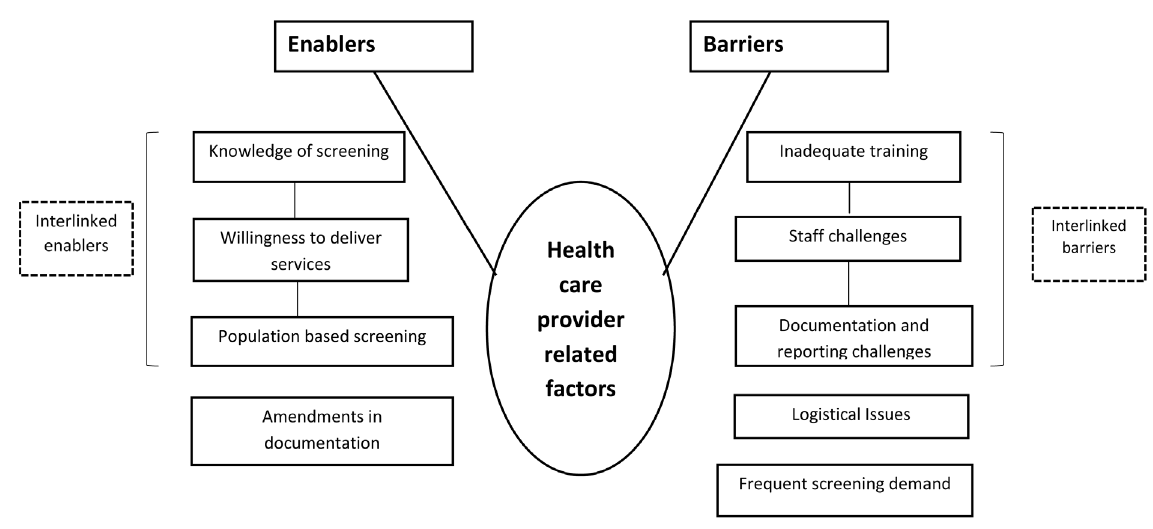
Figure 3. Non-hierarchical thematic map showing enablers and barriers in the implementation of opportunistic screening for diabetes melitus and/or hypertension among persons aged ≥ 30 years seeking health care at the outpatient department in the two selected primary healthcare centres from March to May 2019, as perceived by health care providers.